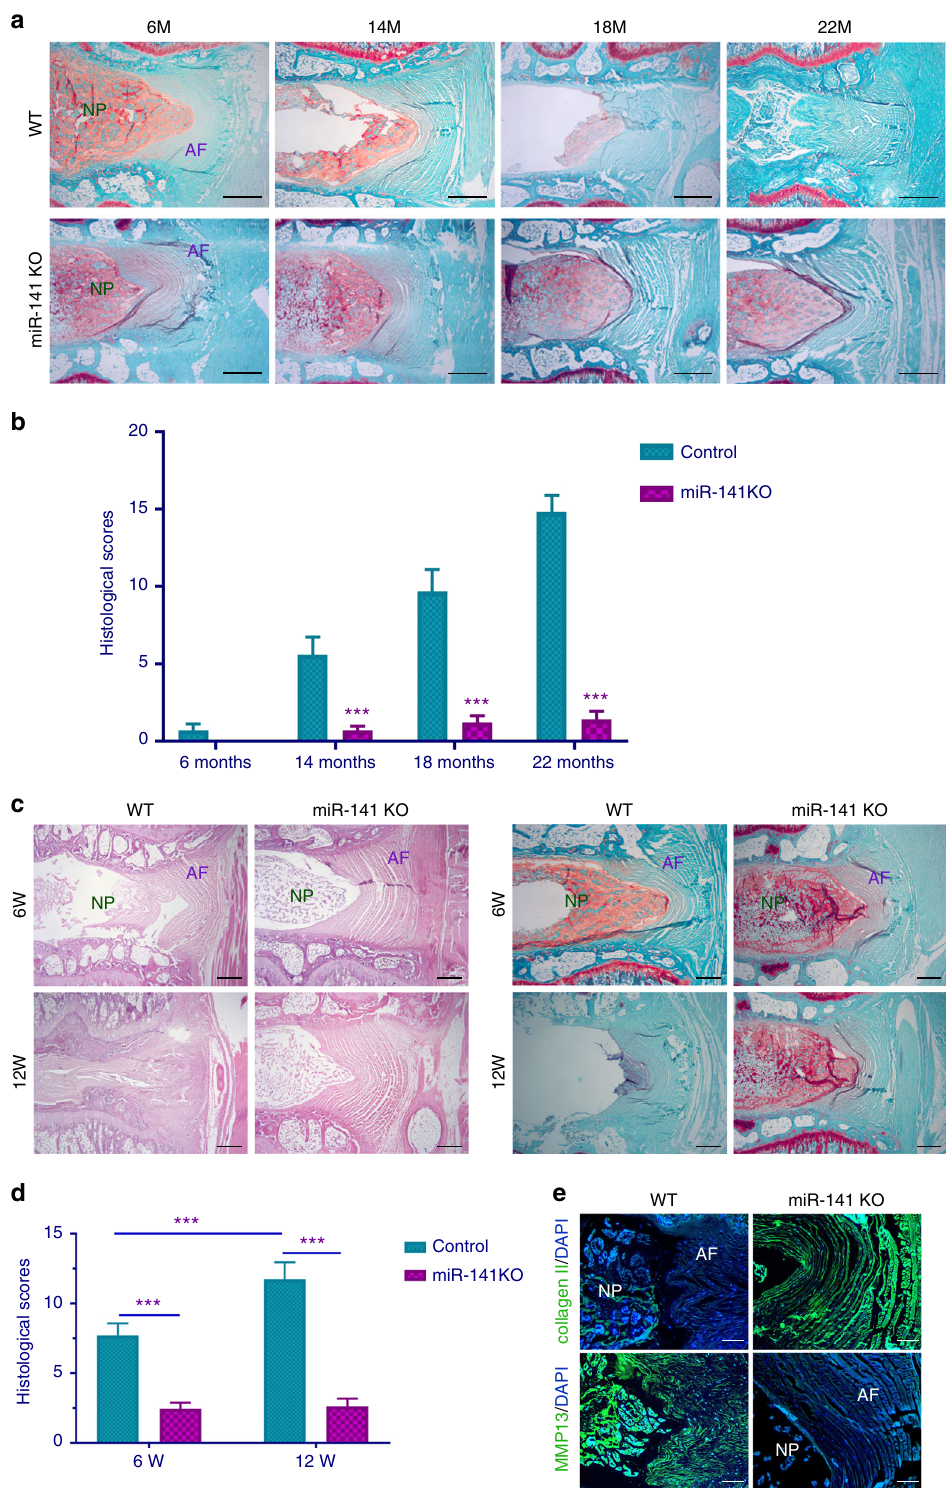
Fig. 2 Genetic deletion of miR-141 suppresses spontaneous and surgically induced IDD. a Safranin O staining of intervertebral disc from 6-month-old mice (WT, n = 10; miR-141 KO, n = 10), 14-month-old mice (WT, n = 10; miR-141 KO, n = 10), 18-month-old mice (WT, n = 10; miR-141 KO, n = 10), and 22- month-old mice (WT, n = 10; miR-141 KO, n = 10). Scale bar = 50 μ m. b The histological grades evaluated at 6, 14, 18, and 22 months in WT and miR-141 KO mice. *** p < 0.001 by unpaired two-sample Student ’ s t test. c HE and Safranin O staining of disc sections in WT and miR-141 KO mice obtained at 6 and 12 weeks after surgery (WT, n = 10; miR-141 KO, n = 10). HE, scale bar = 50 μ m; Safranin O, scale bar = 50 μ m. d Histological score of WT and miR-141 KO mice, as measured through Safranin O result. *** p < 0.001 unpaired two-sample Student ’ s t test. e Immunostaining for collagen II and MMP13 in discs of WT and miR-141 KO mice. Scale bar = 100 μ m. Data shown as mean and error bar represents